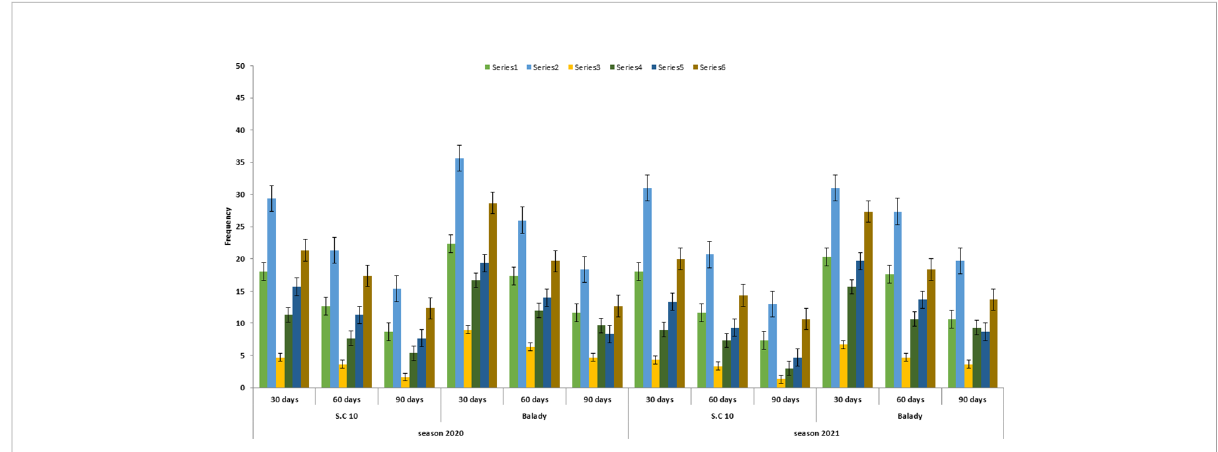
FIGURE 2 F. verticillioides frequency % from roots under different soil treatments at different times after the sowing date during the 2020 and 2021 growing